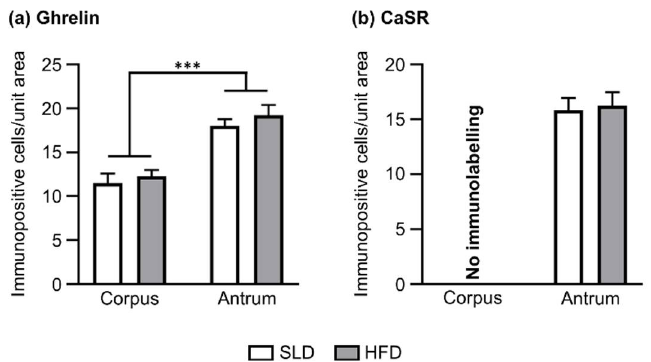
Figure 3. Density of ghrelin and CaSR immunopositive cells in the glandular base of gastric corpus and antrum of mice fed standard laboratory diet (SLD, n = 5) or high-fat diet (HFD, n = 5) for 12 weeks. ( a ) Cell counts showed a higher density of ghrelin cells in the glandular base of the gastric antrum than corpus. A comparable number of ghrelin cells was observed in the corpus of SLD and HFD mice. Similarly, comparable numbers of ghrelin cells were found in the antrum of SLD and HFD mice. ( b ) CaSR cells were located in the antrum only, with no immunolabelling observed in the corpus. A comparable number of CaSR cells were observed in the antrum of SLD and HFD mice. Cell counts are the mean value of 5–6 non-adjacent tissue sections per mouse and gastric region (unit area = 159 × 159 µm). Two-way ANOVA followed by Sidak post hoc test was used to assess the differences in the number of ghrelin cells, and unpaired Student’s t -test was used to assess differences in the number of CaSR cells. *** p < 0.001.